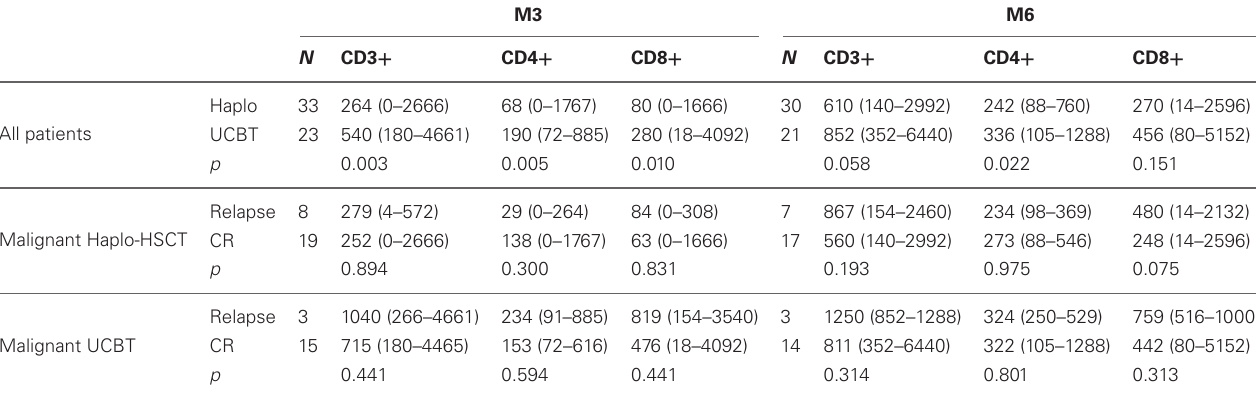
Table 2 | Median number (range) of circulating T-lymphocyte subsets three (M3) and six (M6) months after HSCT (cells × 10 3 / µ